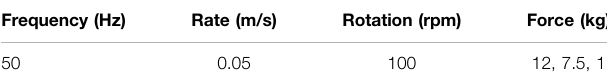
TABLE 2 | The Characteristics of the instrument developed for abrasion test.